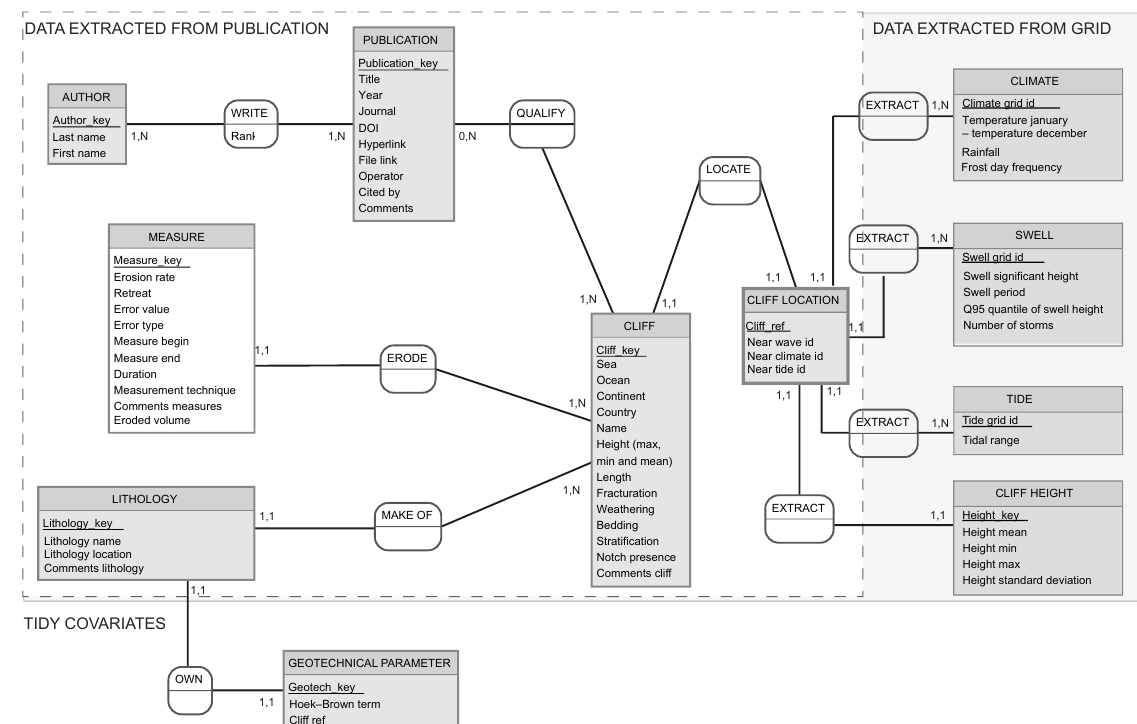
Figure 3. Conceptual data model of the GlobR2C2 cliff erosion database. Primary keys are underlined and numbers are cardinalities.